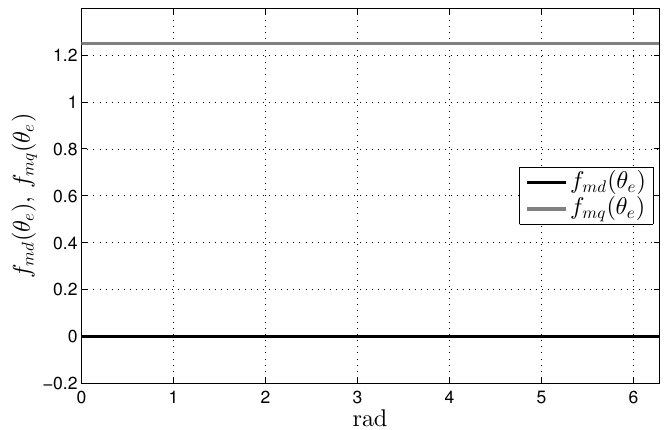
Figure 3. Back-EMF fundamental functions f md ( θ e ) and f mq ( θ e ) in modified- ( d , q ) reference frame